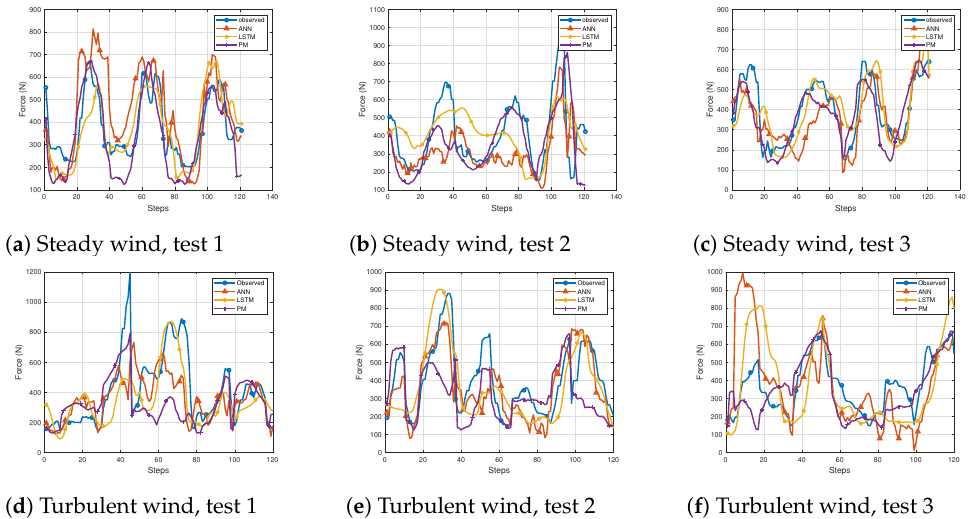
Figure 21. Combined analysis of tether force estimation methods–physical, ANN, and LSTM methods: ( a – c ) the three tests under steady wind conditions, ( d – f ) the three tests under turbulent wind conditions. The error parameters for the three methods were compared with three different error parametrics—the root mean square error (RMSE), mean absolute error (MAE), and R- squared ( R 2 )